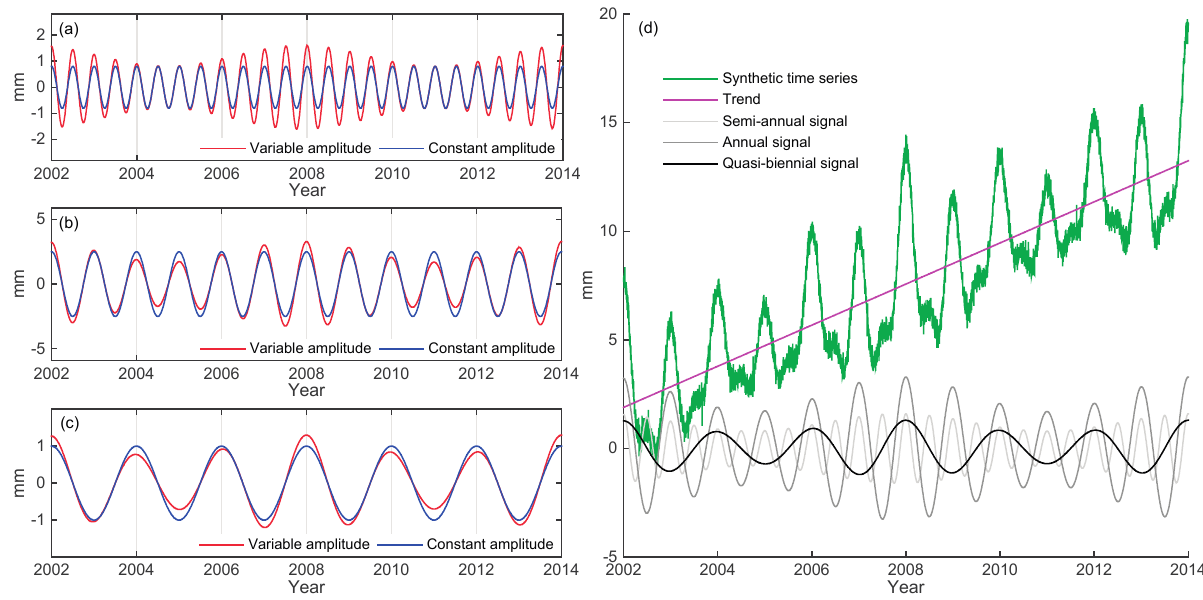
( t ) , with time-invariant (red) and i